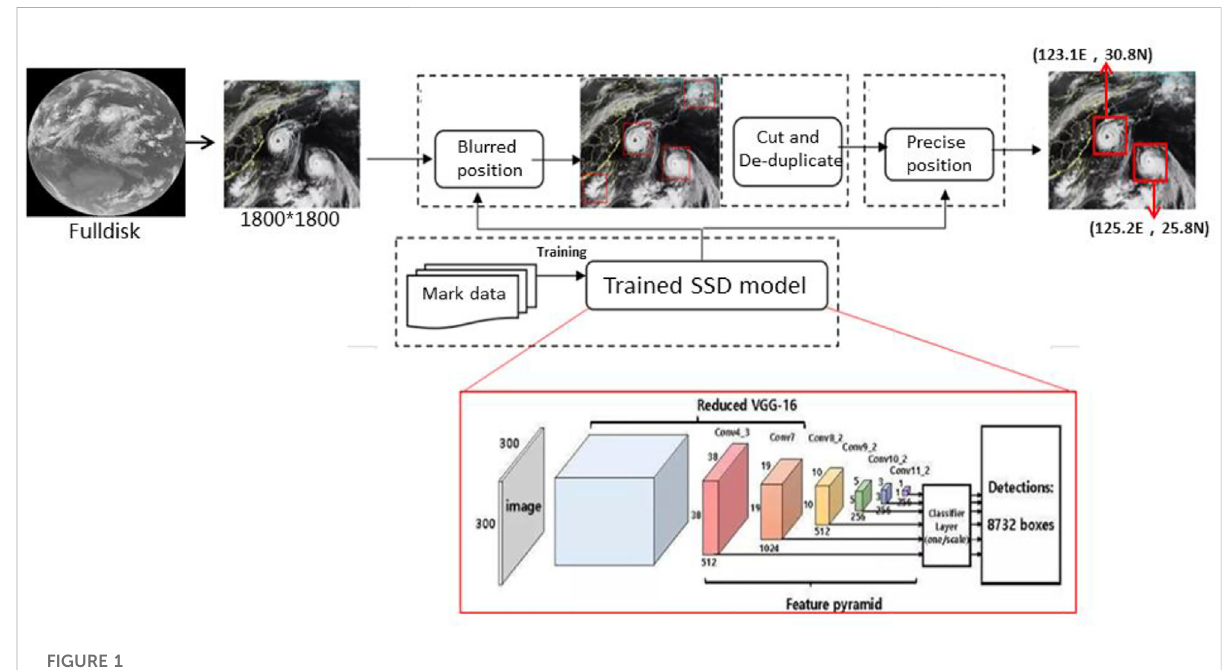
FIGURE 1 Flowchart of vortex recognition model based on depth image target detection.